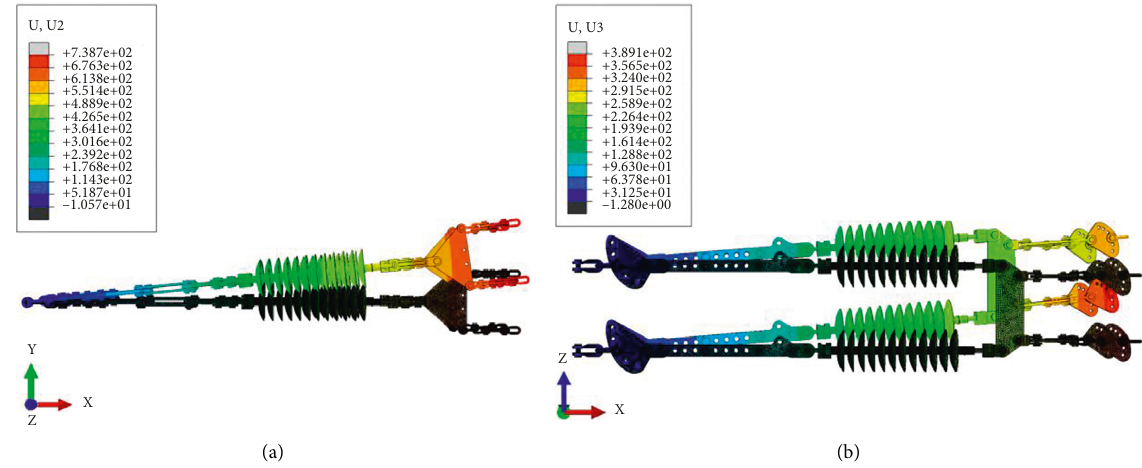
Figure 25: Displacement cloud picture of tension string (mm): (a) In X–Y plane, (b) In X–Z plane.